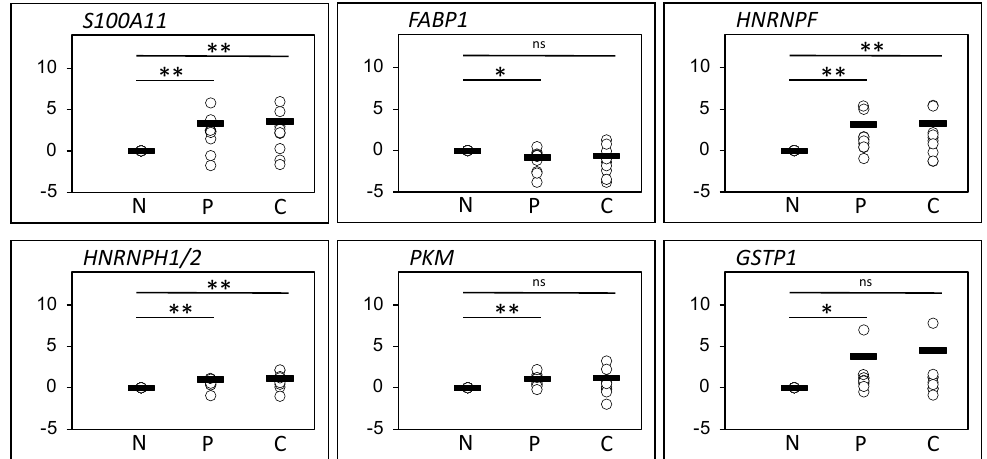
Figure 3. Quantification of S100A11 , FABP1 , HNRNPF , HNRNPH1/2 , PKM and GSTP1 . Relative pixel intensities are depicted as log 2 -transformed values in the dot plots. Quantification was performed as indicated in the legend to Figure 2. * p < 0.05; ** p < 0.01, ns; not significant.